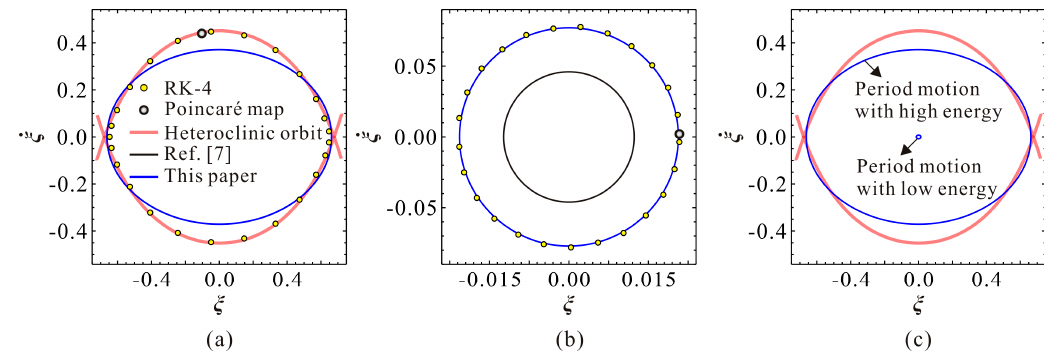
Figure 4. Phase diagram corresponding to Figure 3a for ω = 0.56. ( a ) Phase diagram with relatively high vibration energy, initial condition ( − 0.100427, 0.441685); ( b ) phase diagram with relatively low vibration energy, initial condition (0, 0); ( c ) a specific comparison of the phase diagrams in ( a , b ).